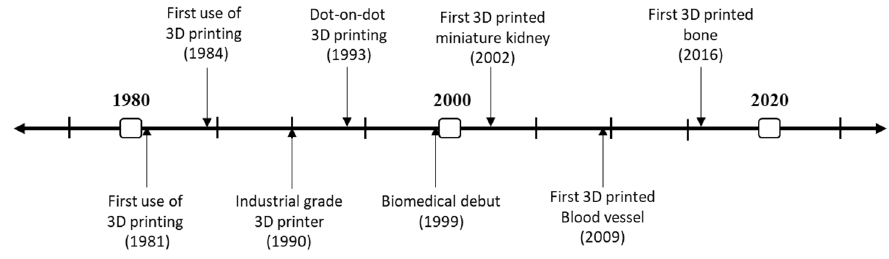
Figure 4. Timeline of the evolution of “3D printing” over history.